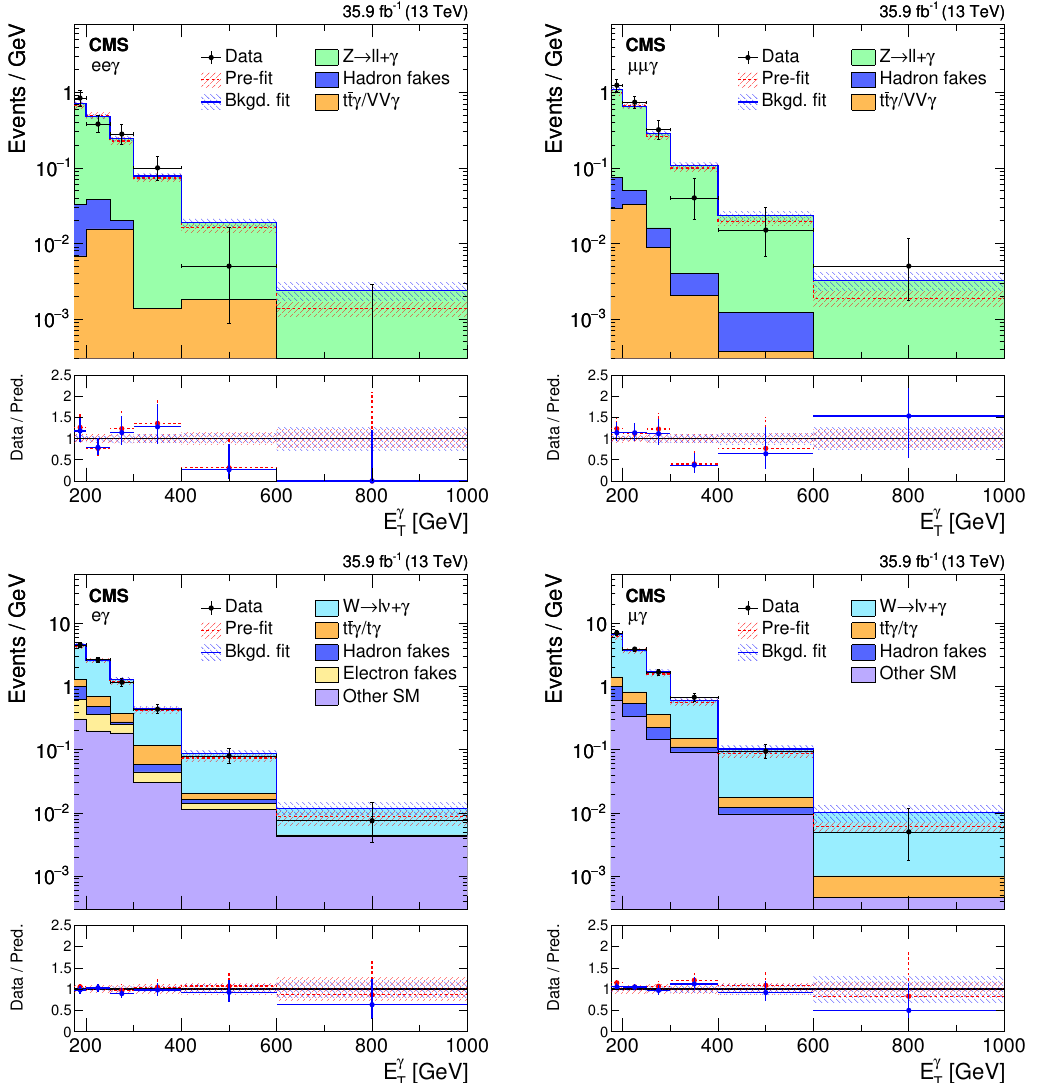
Figure 5 . Comparison between data and MC simulation in the four control regions: ee (cid:13) (upper left), (cid:22)(cid:22)(cid:13) (upper right), e (cid:13) (lower left), (cid:22)(cid:13) (lower right) before and after performing the simultane- ous (cid:12)t across all the control samples and signal region, and assuming absence of any signal. The last bin of the distribution includes all events with E (cid:13) > 1000 GeV. The ratios of data with the pre-(cid:12)t T background prediction (red dashed) and post-(cid:12)t background prediction (blue solid) are shown in the lower panels. The bands in the lower panels show the post-(cid:12)t uncertainty after combining all the systematic uncertainties.